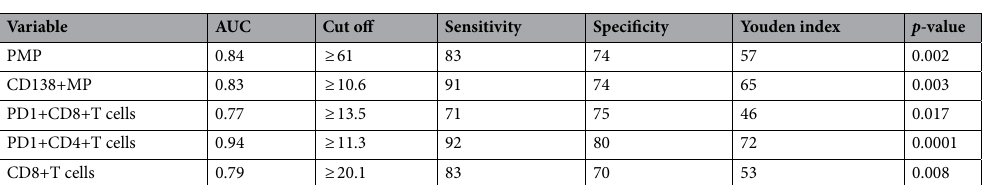
Table 6. Performance of different MPs and immune cells in MM. AUC: area under the curve; PMP: platelet microparticles; MP: microparticles; PD1: programmed death-1.